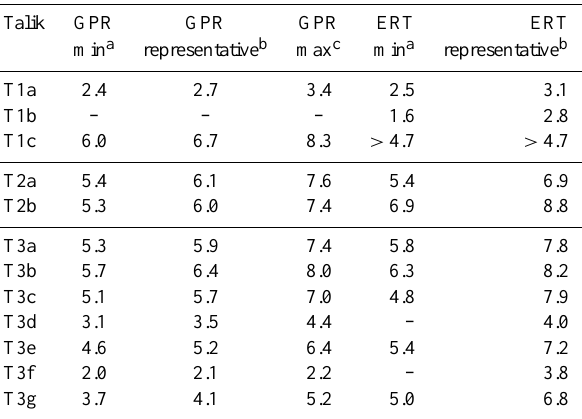
Table 3. Estimated depths (m) of taliks at deepest point. Numbering is the same as in Fig.